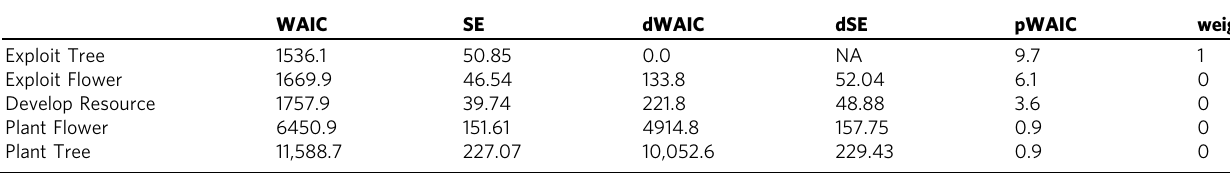
Table 5 Model comparison.